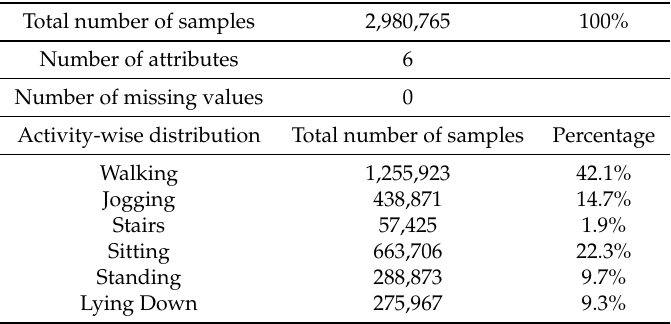
Table 3. Actitracker dataset description.